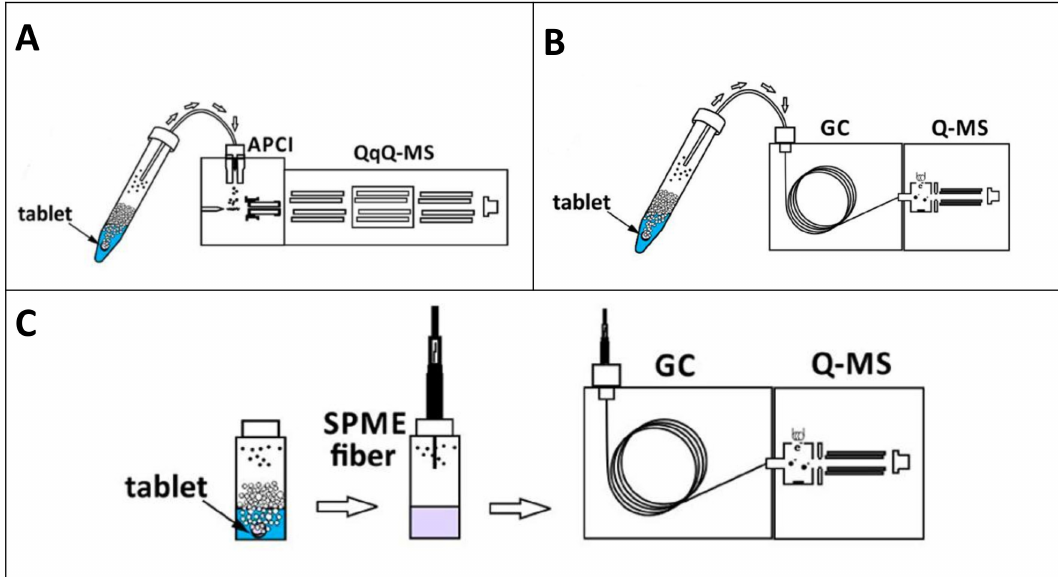
Figure 7. Use of e ff ervescence tablets for fizzy extraction. ( A ) Coupling with mass spectrometry; ( B ) coupling with gas chromatography; and ( C ) coupling with solid-phase microextraction. Adapted with permission of the American Chemical Society from